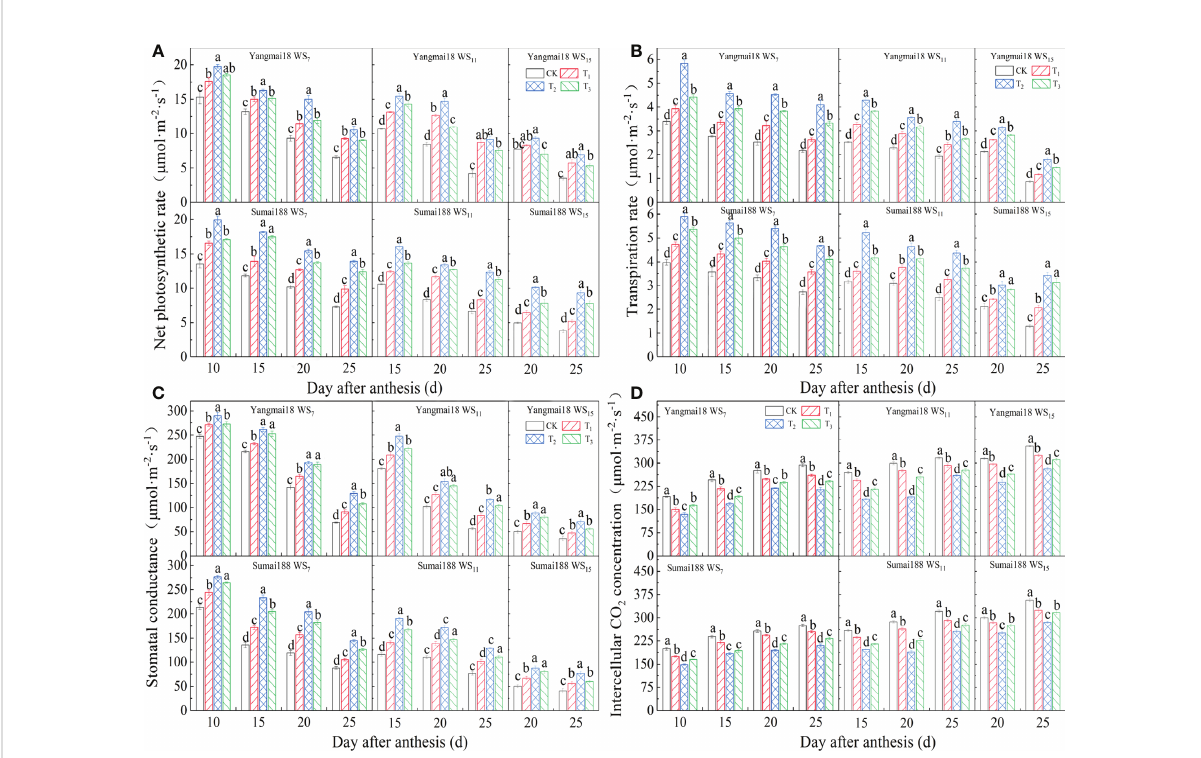
FIGURE 5 The effect of exogenous 6-BA on Pn (A) , Tr (B) , Gs (C) , Ci (D) of wheat under waterlogging and shading in 2021. WS 7 , WS 11 , and WS 15 respectively represent treatments under waterlogging and shading for 7, 11, and 15 days after anthesis. Shade nets with a shading rate of about 45% were used for shading, and waterlogging preserves about 2 cm of moisture on the surface of the soil. CK refers to the control sprayed with distilled water. T 1 , T 2 , and T 3 refer to the concentrations of 6-BA sprayed (15, 25, and 35 mg·L − 1 ). Each value is expressed as mean ± SE ( n = 3). Different lowercase letters embedded at the top of the histogram express signi fi cant differences between treatments ( p<